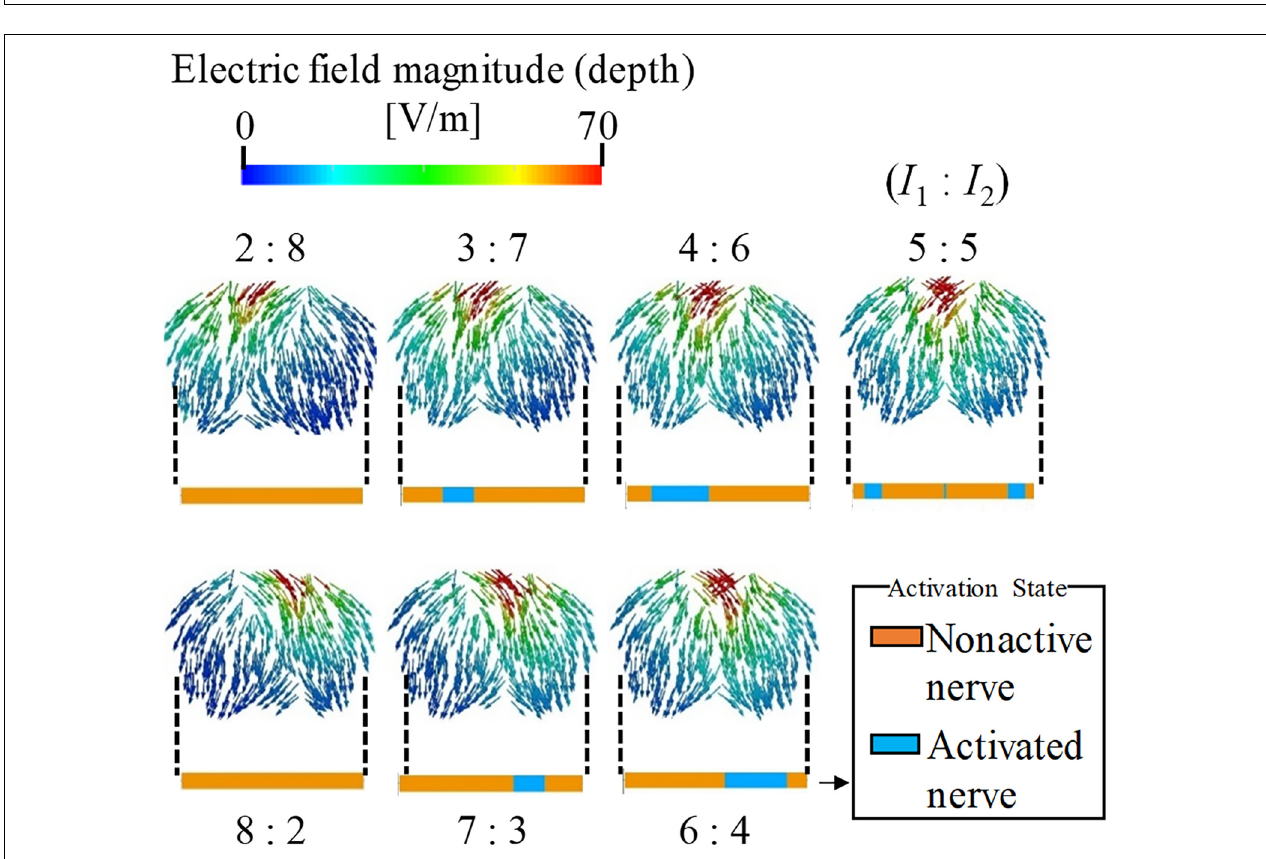
FIGURE 4 | Stimulation regions of different stimulation conditions ( I 1 : I 2 ). The electric field vector direction was modified according to the injection current ratio (transverse plane). The magnitude is given by the envelope depth (see definition in Figure 2 ). Effects on neural activation are shown by the activation region that represents the state of the axon (active or non-active) for the different injection current ratios.